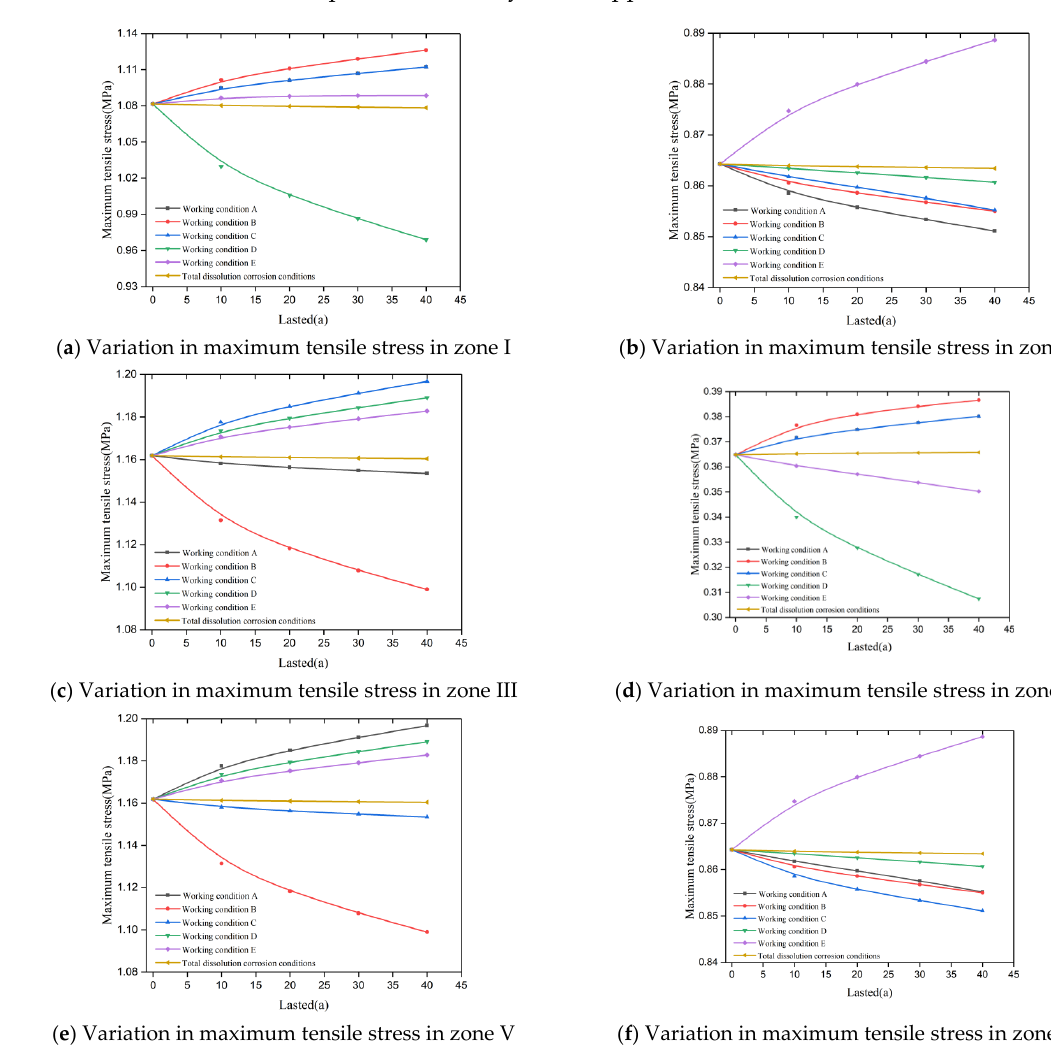
Figure 12. Variation in maximum stress in each area with increasing dissolution. 4.3. Change in Surface Settlement Induced by Culvert Dissolution The changes in surface lateral settlement curves at 10, 20, 30, and 40 years due to concrete deterioration caused by contact dissolution occurring at different locations along the culverts are shown in Figure 13; the following patterns can be found: